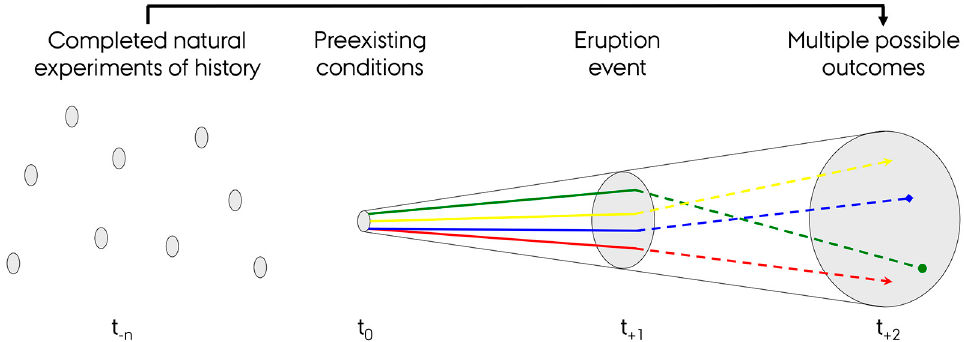
Figure 4. Mazzorana et al.’s (2009) scenario trumpet extended to include the complete natural experiments of history that (indicated by the arrow) inform the societal aspects of such disaster scenarios. Traditionally, the scenario trumpet begins at t 0 , our present, and lets a given event unfold over some future time-span, t +1 , t +2 , t +n . In the extended model offered here, evidence for concrete impacts and their mechanisms from numerous past cases at t -n are added to provide a patchwork of relevant evidence that can be harnessed in constructing realistic scenarios, while a specific event— here the Laacher See eruption 13,000 years ago—serves as a concrete starting point for the scenario at t 0